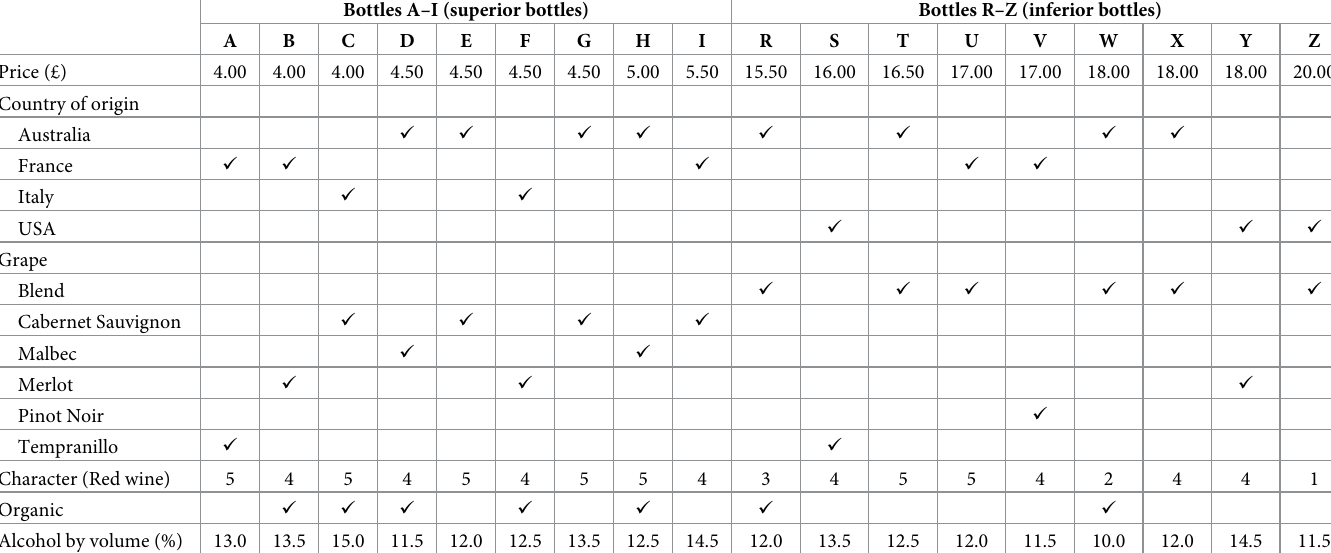
Table 8. Bottles considered in scenario